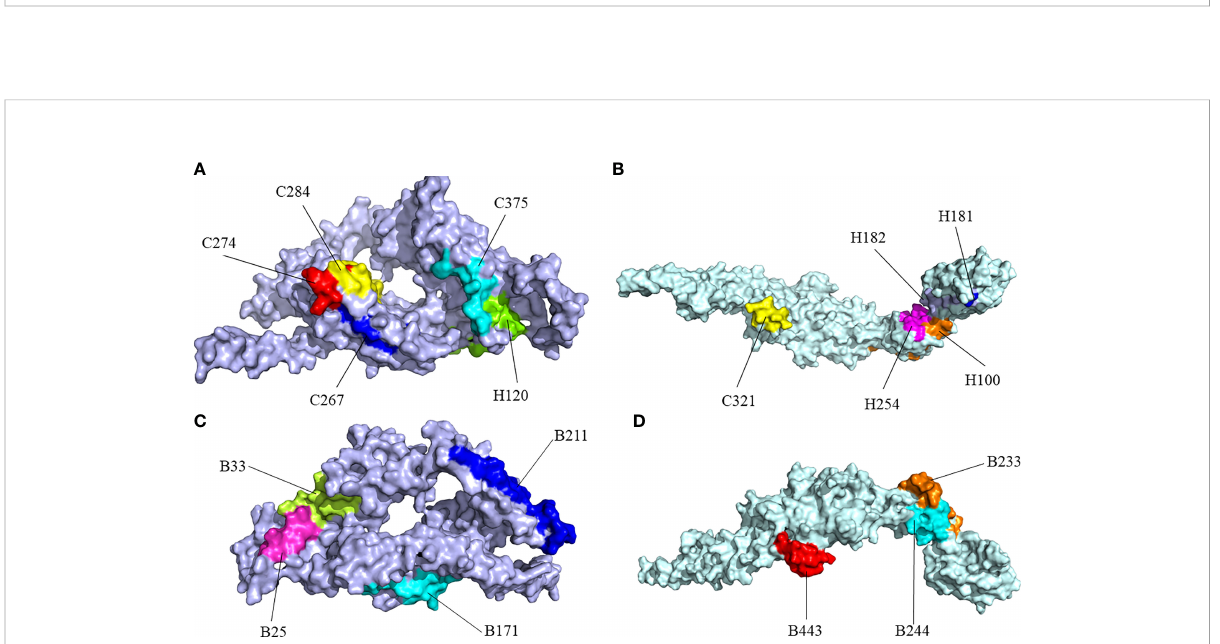
FIGURE 4 Surface positions of fi nal selected epitopes on the three-dimensional (3D) models of the protein. (A) The Cytotoxicity T Lymphocytes (CTL) epitopes and helper T lymphocyte (HTL) epitopes of CdeC. (B) The CTL epitopes and HTL epitopes of FliD. (C) The B-cell epitopes of CdeC. (D) The B-cell epitopes of FliD. Every CTL epitope is represented by a combination of C and its starting position. Every HTL epitope is represented by a combination of H and its starting position. Every B-cell epitope is represented by a combination of B and its starting